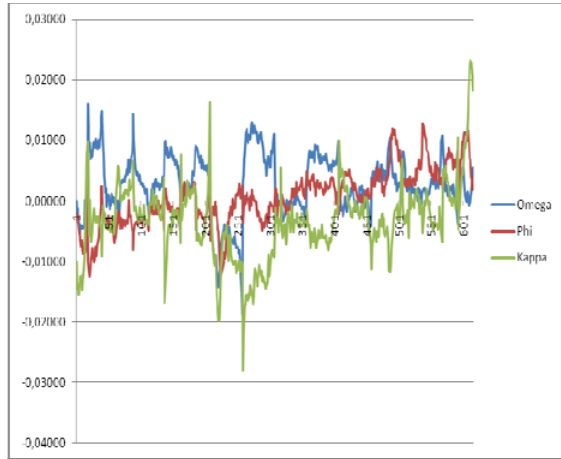
Table 5. Statistics of Position parameter from GPS/IMU